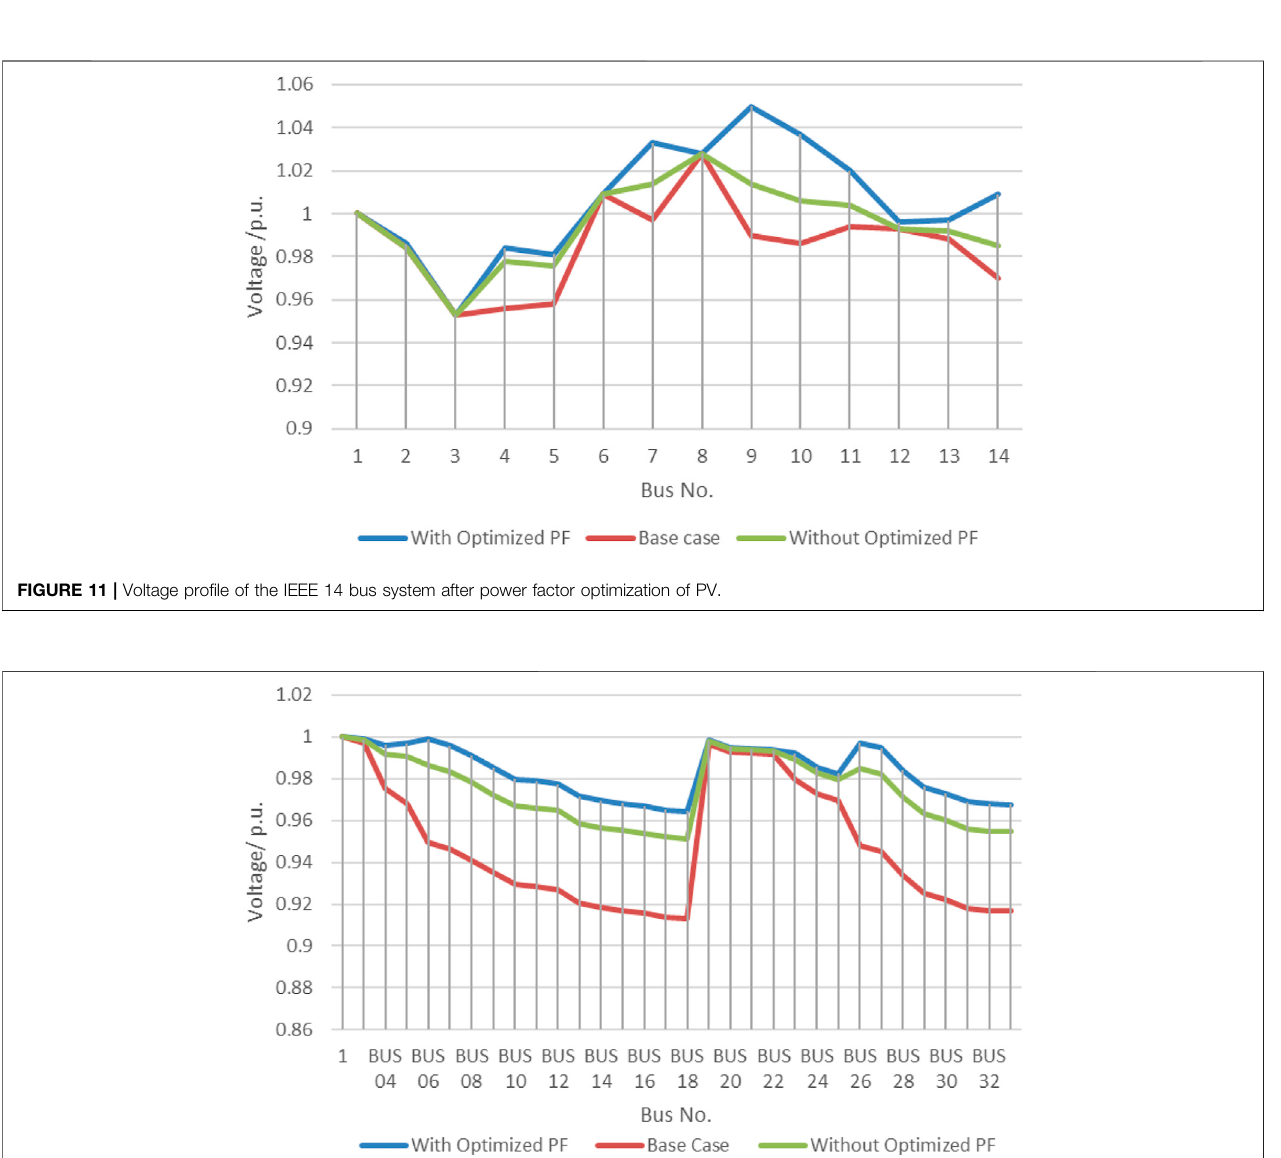
FIGURE 12 | Voltage pro fi le of the IEEE 33 bus system after power factor optimization of PV.